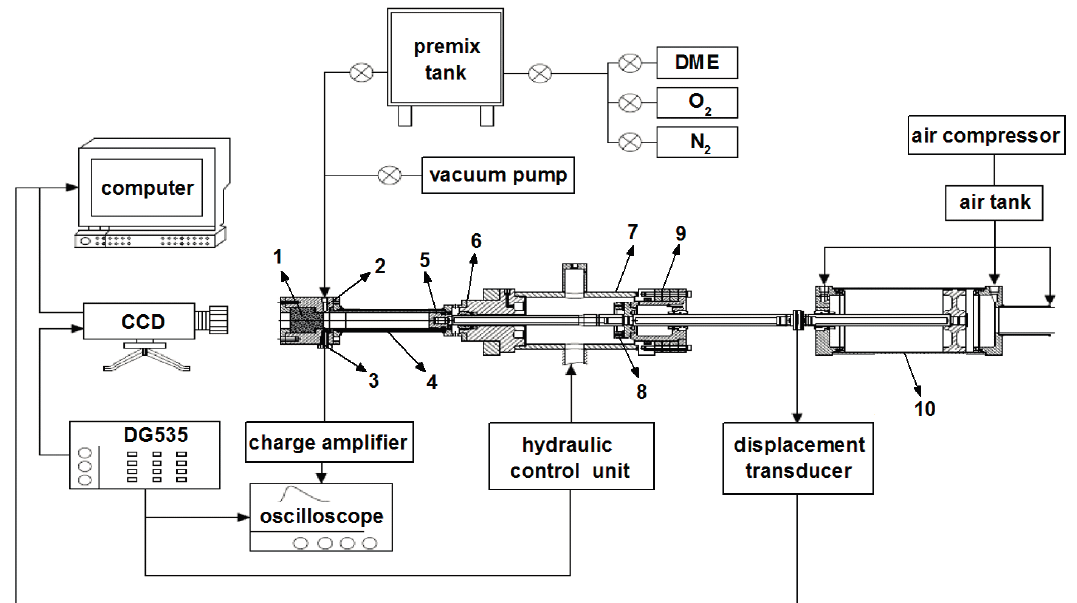
Figure 1. Schematic diagram of the rapid compression machine (RCM) test